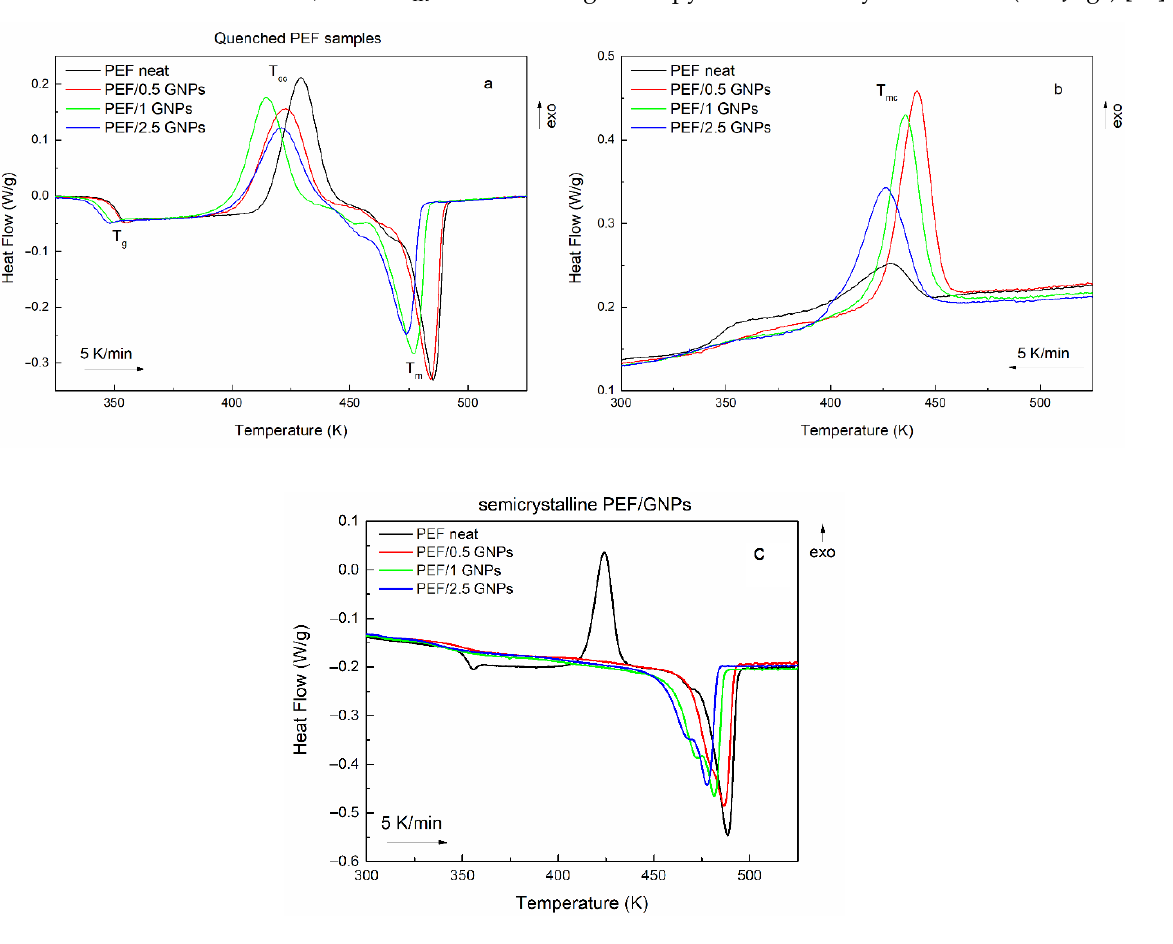
Figure 2. Heating curves of the quenched neat PEF and PEF/GNP nanocomposites ( a ), their subsequent cooling curves ( b ), and their heating curves after their melt crystallization ( c ) (the heating/cooling rate is 5 K/min). Table 1. Glass transition, cold crystallization, melting temperatures, and enthalpies of the quenched neat PEF and PEF/GNP nanocomposites and their subsequent melt crystallization temperatures and enthalpies at a heating/cooling rate of 5 K/min.